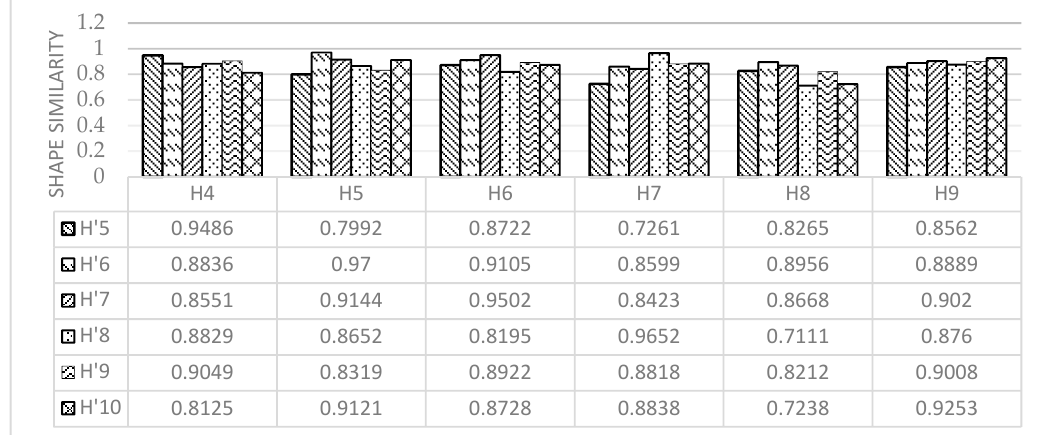
Figure 18. Shape similarities of the inner contours of Lake Huron.